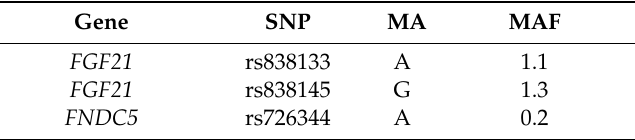
Table A3. List of SNPs discarded for analyses because the frequency of the minor allele was inferior to